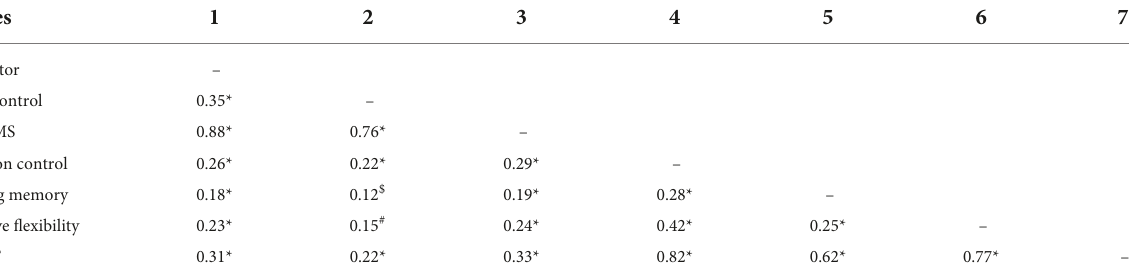
TABLE 2 Partial correlation outcomes of measured